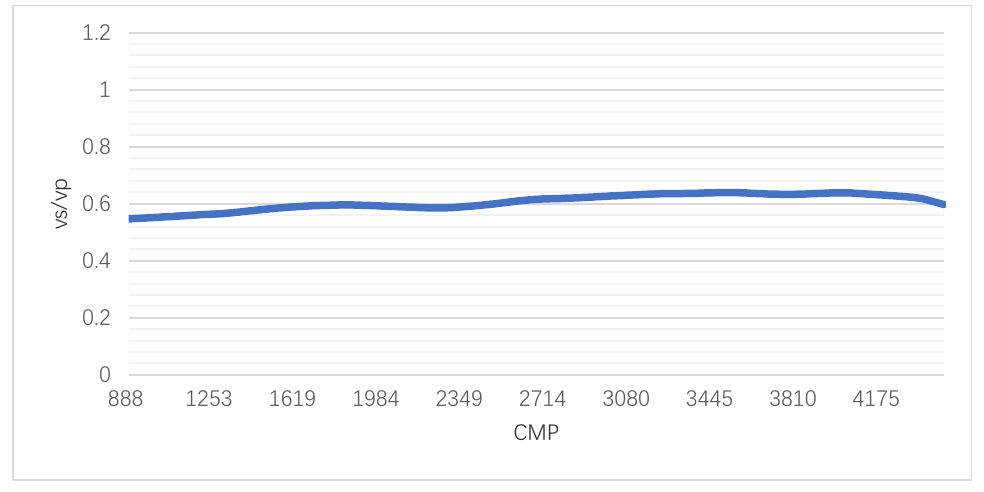
Figure 7. Pre-stack time migration (PSTM) sections: ( a ) P-wave and ( b ) SH shear wave.